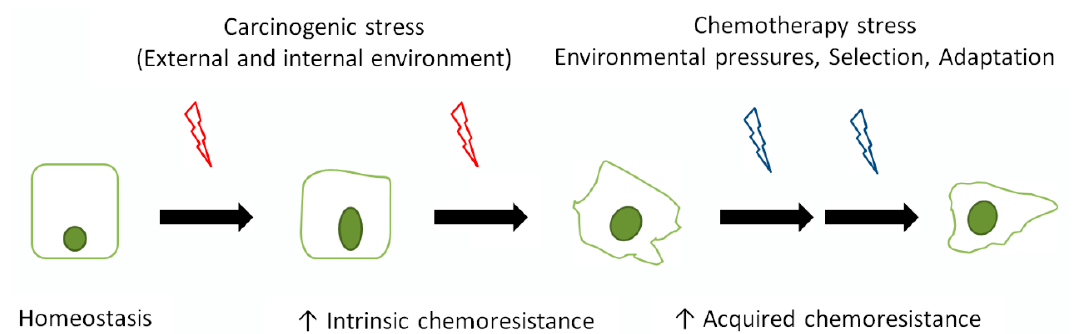
Figure 1. Development of intrinsic and acquired chemoresistance in the process of colorectal carcinogenesis. During malignant conversion, individual cells are exposed to carcinogenic events from external and internal environments, which prompt the gradual development of intrinsic chemoresistance to mediate cell survival. During advanced stages of carcinogenesis and upon exposure to chemotherapy-related stress combined with selection-adaptation-related pressures, malignant cells develop acquired chemoresistance.